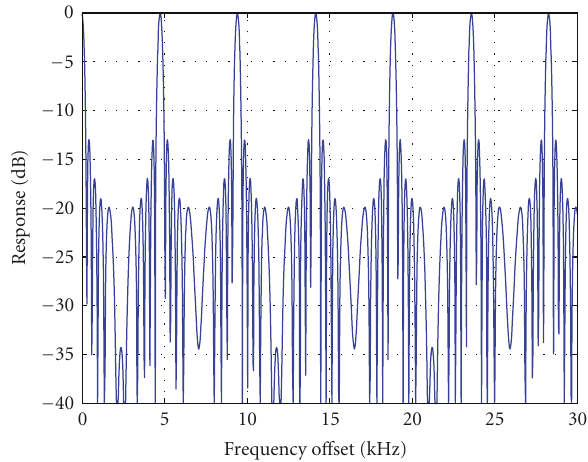
Figure 4: The beam directs to a target at (50km, 0 0 ) with di ff erent frequency o ff